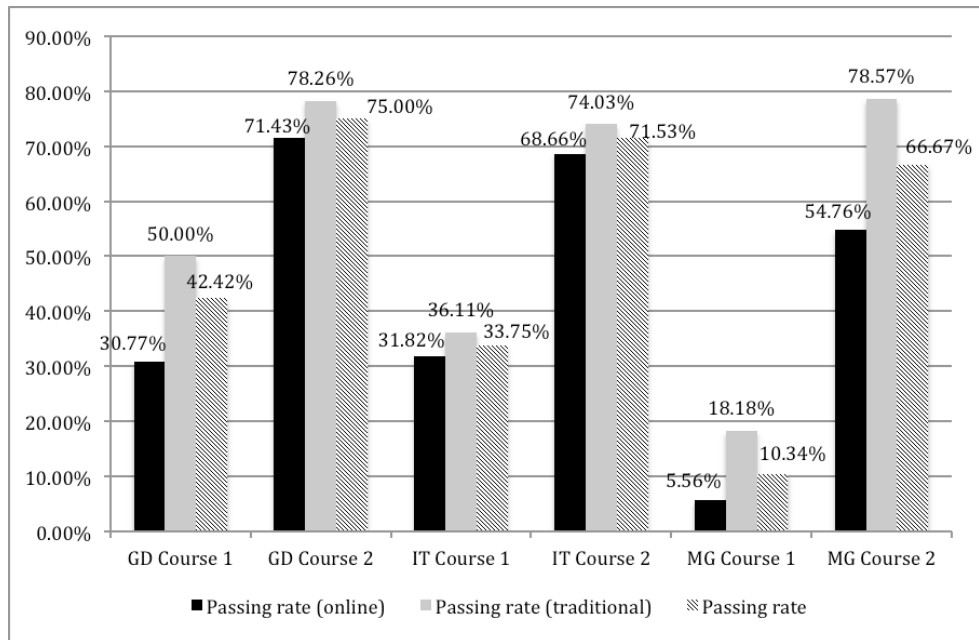
Figure 2 . Taken-exam and passing rates for individual